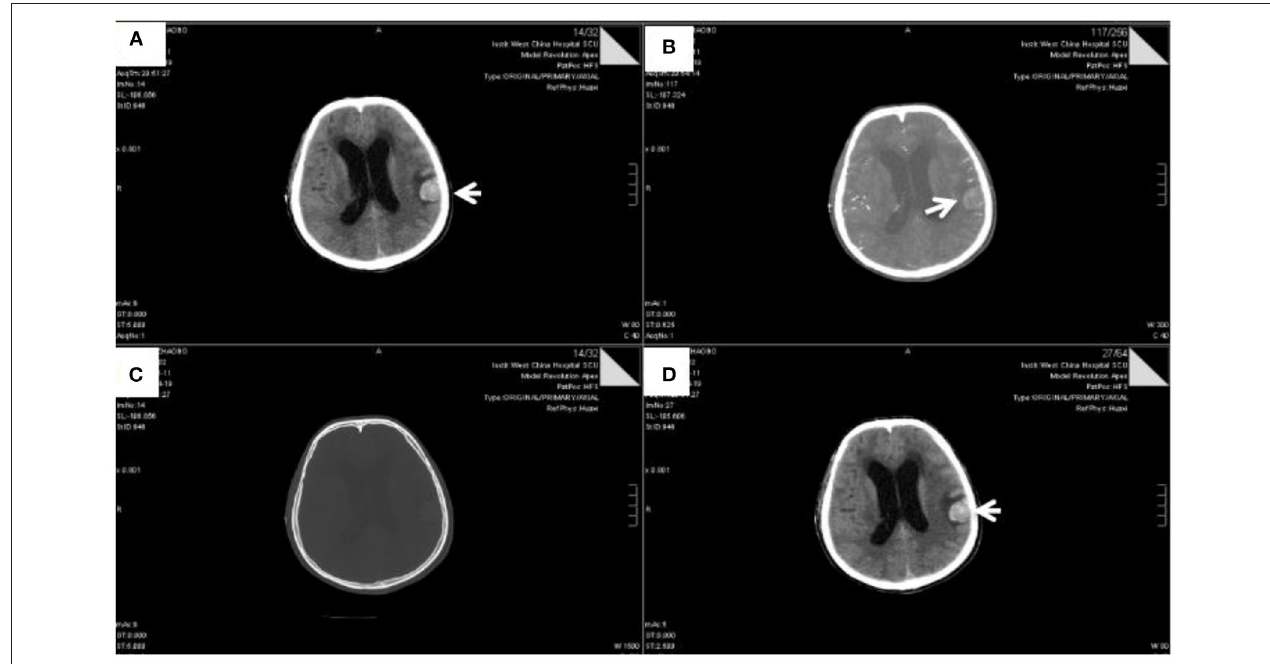
FIGURE 1 | The head CTA scan of patient (Apr 19, 2021). Slightly high-density nodules were observed in the left frontal lobe and temporal lobe. The largest nodules were located in the frontal lobe, with a size of about 2.8 × 2.4cm (Arrow indicating part). Shadow shuttling of arterial vessels was observed at the edge, without obvious thickening and tortuosity. The intraventricular system was hydrocephalic and dilated, accompanied by interstitial cerebral edema. Some sulci in bilateral cerebral hemispheres became narrow and unclear, and the density of tentorium cerebellum increased